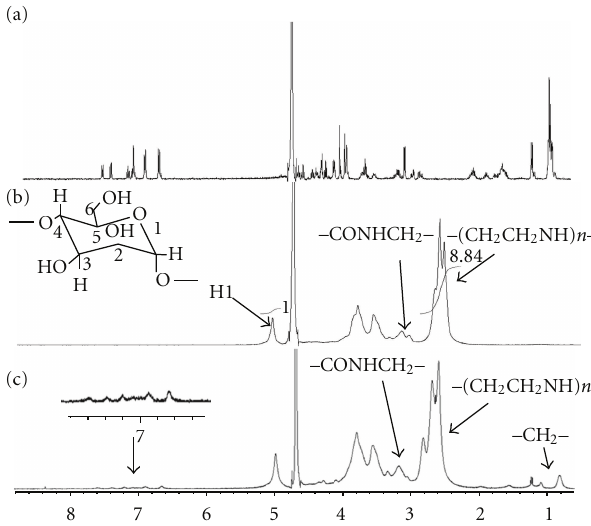
Figure 1: 1 H-NMR analysis of (a) CY11, (b) PEI- β -CyD, and (c) CY11-PEI- β -CyD. The peaks at 2.5–3.2 ppm are assigned to the protons of PEI600 in (b) and (c). At 0.8–1.3 and 6.7–7.6 ppm, the new peaks are assigned to the protons of the amino acids of CY11 in (a) and